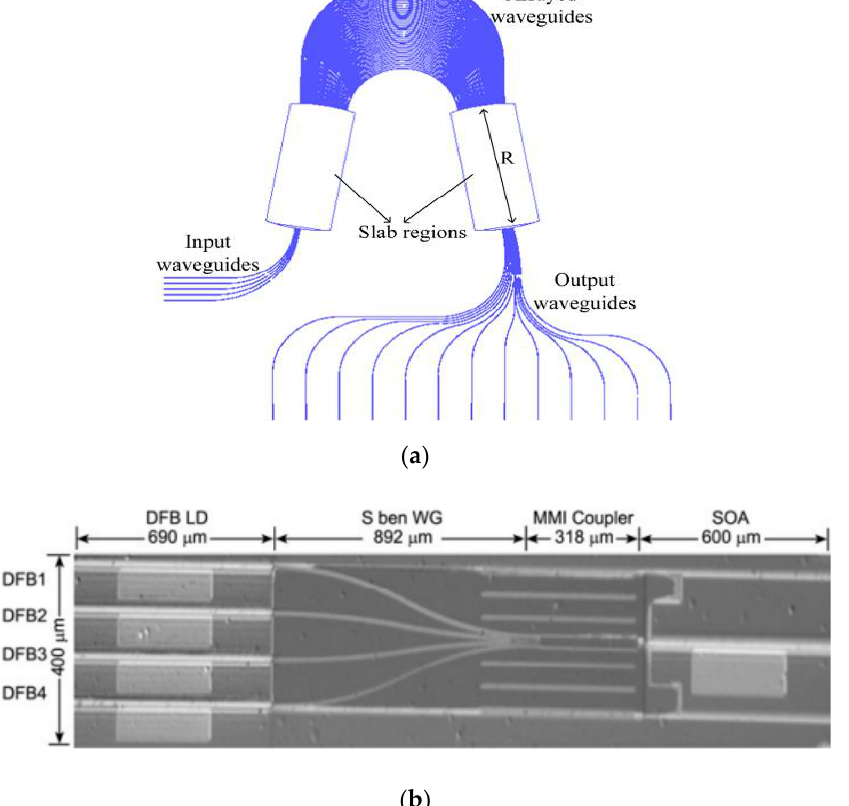
Figure 2. Schematic diagram of different couplers, ( a ) AWG [10] and ( b ) MMI [11] . © ( a ) Elsevier. Copyright 2015 optics communications. ( b ) Springer link. Copyright 2013 Science China Information Sciences.